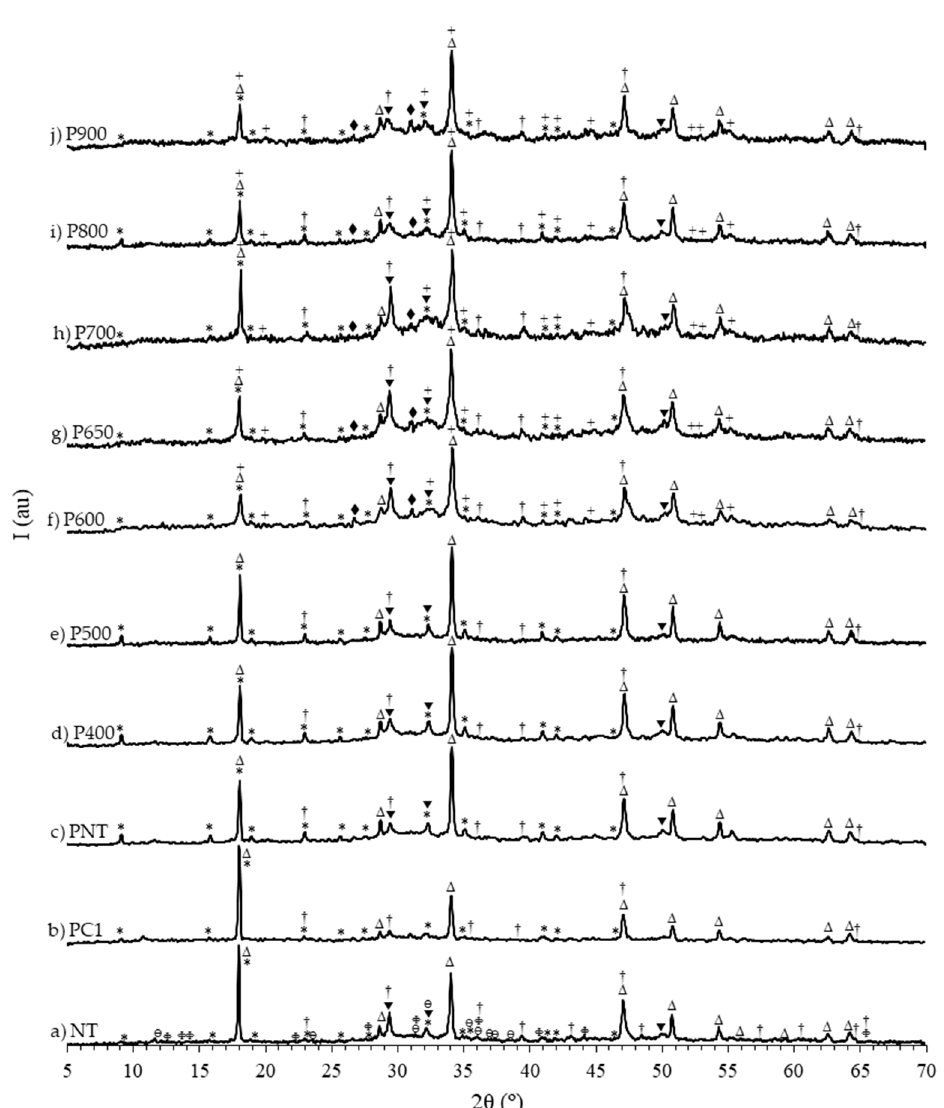
Figure 21. XRD analysis of NT at 90 days and PC1, PNT and RC pastes at 28 days. ∆ CH (portlandite); † CaCO 3 (calcite); * AFt (ettringite); θ C-S-H; C-S-H; tobermorite; + C2S; Φ alumohydrocalcite; θ calcium aluminum oxide carbonate hydrate.